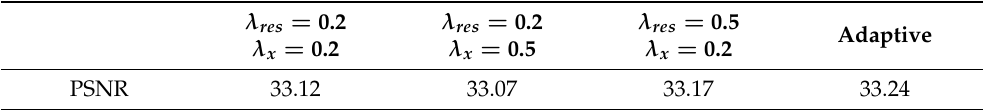
Table 2. Comparison of the average PSNR (dB) metric of the models corresponding to different weights on Set14 (×2) in 2.5 × 10 4